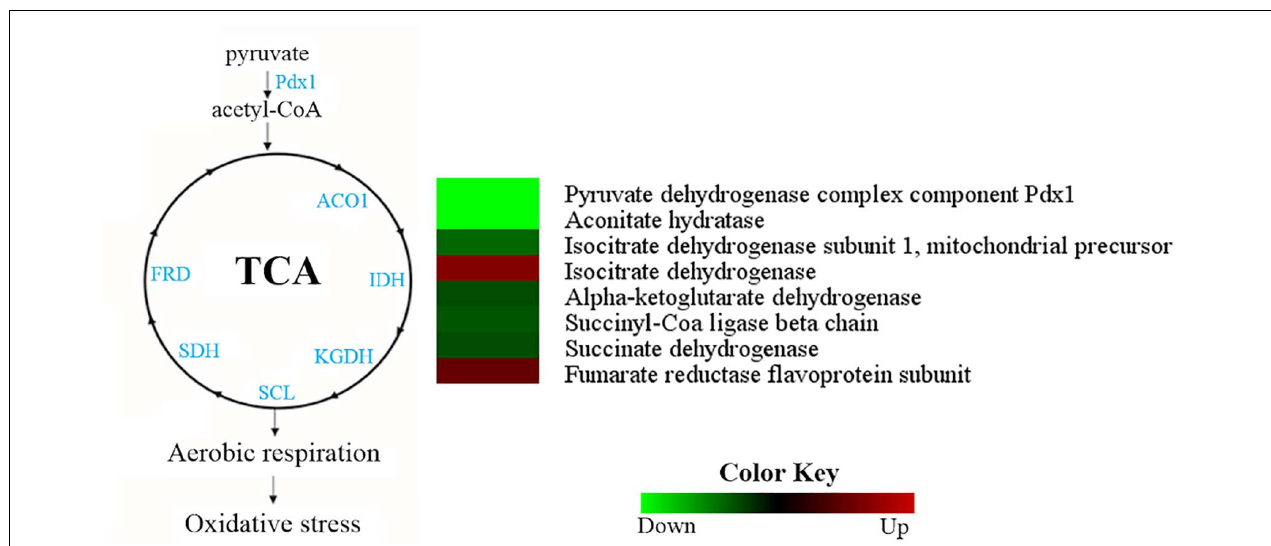
FIGURE 6 | Comparison of protein profiles related to tricarboxylic acid (TCA) cycle and oxidative phosphorylation in H. capsulatum mycelium and yeast forms. Dataset comparisons were carried out as cited in the Figure 2 legend. The diagram representing the metabolic pathways of TCA cycle and oxidative phosphorylation represents differentially abundant proteins in the mycelium and yeast phases. Changes in the abundance levels in the mycelium compared with the yeast are represented in the heat map. Experimental triplicate mean values are presented for the lowest (green) and the highest (red) abundance of H. capsulatum proteins in the mycelium form. Black indicates that no significant difference was observed. Pdx1, pyruvate dehydrogenase; ACO1, aconitate hydratase; IDH, isocitrate dehydrogenase; KGDH, alpha-ketoglutarate dehydrogenase; SCL, succinyl-Coa ligase; SDH, succinate dehydrogenase; FRD, fumarate